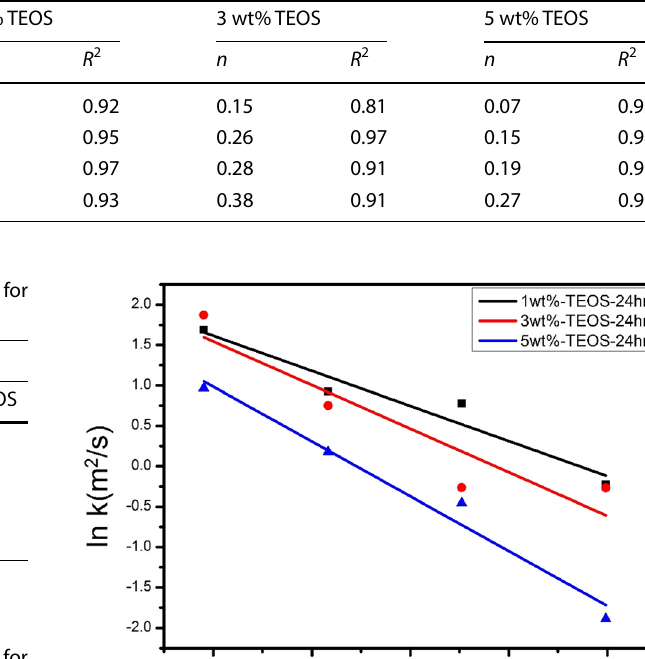
Table 6 Growth rate for samples coated with TEOS and reacted for 48 h after soldering at various temperatures Soldering tem- perature